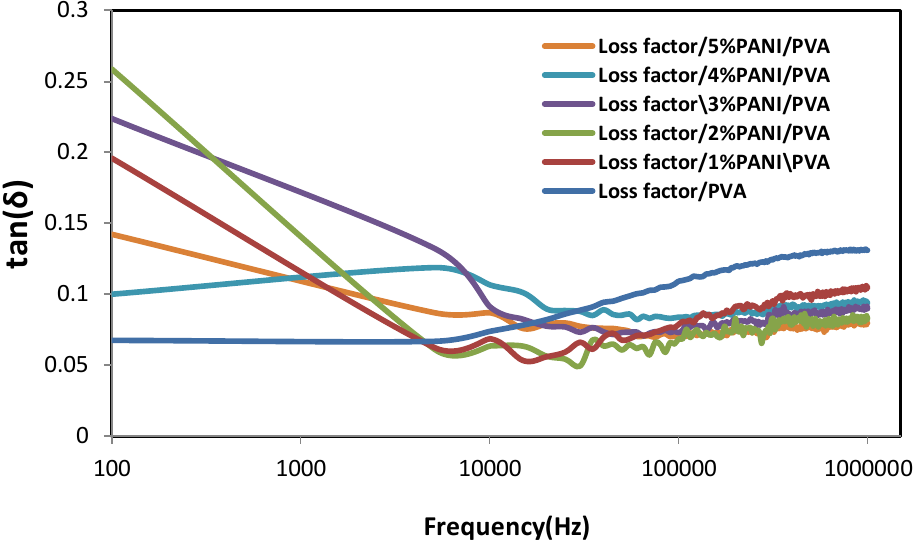
Figure 5: loss factor (tan δ) as a function of frequencies for PVA before and after PANI